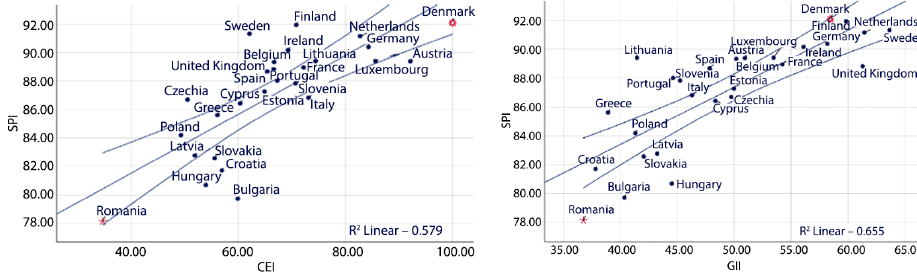
Figure 4. The correlation between SPI and CEI (source: created by the authors) and The correlation between SPI and GII (source: created by the authors) Measuring social progress is necessary because it can underpin the development strate- gies of EU states. Statistical data show high levels of social progress in the Nordic countries, the Netherlands, Austria, Germany, Luxembourg and the United Kingdom. Estonia and the Czech Republic have good scores on the social progress index, although they are not cor- related with their relatively low level of